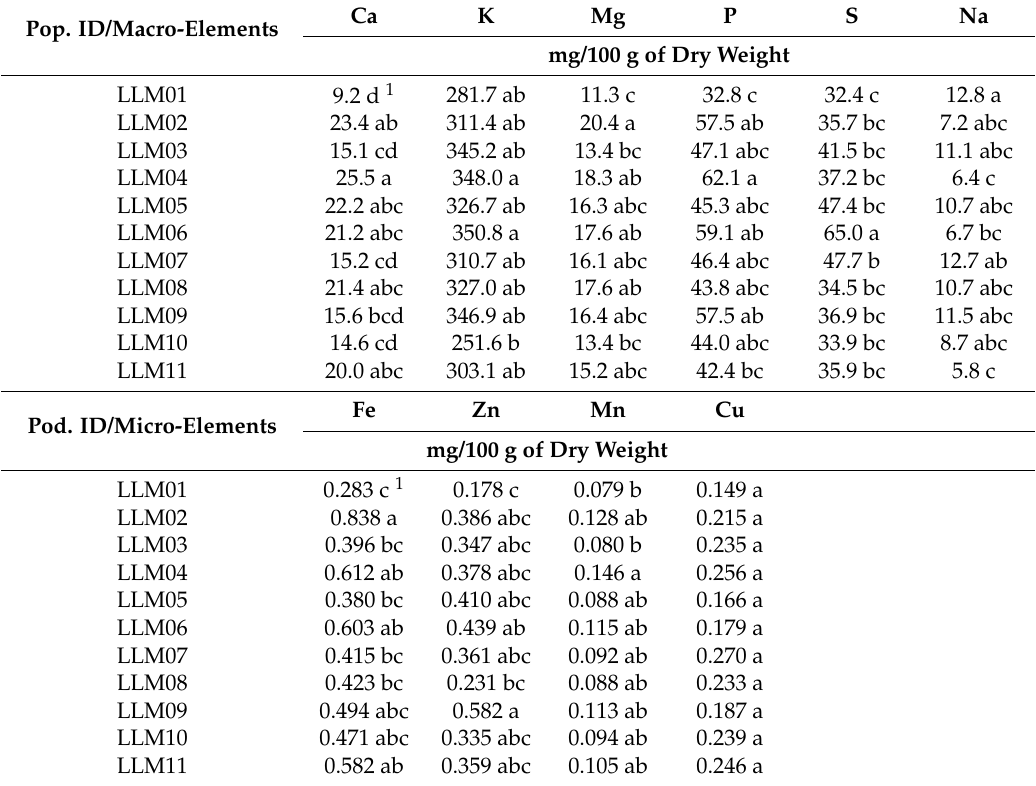
Table 6. Mean comparisons for minerals in the fruit of eleven tomato accessions from El Salvador. Pop.